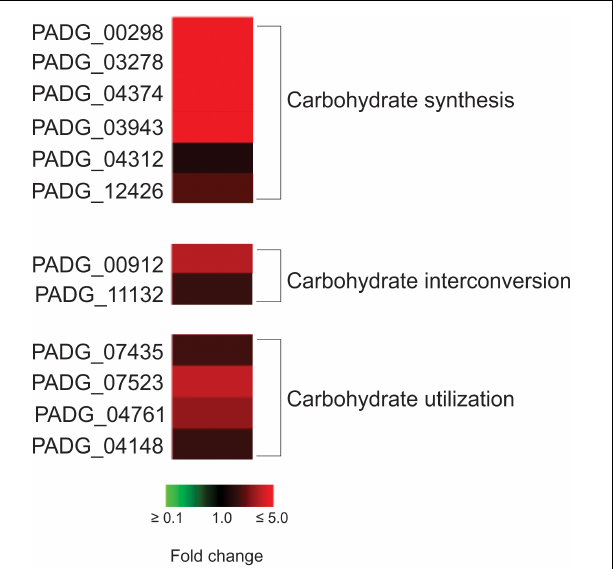
FIGURE 4 | Heat map of proteins related to carbohydrate synthesis, interconversion, and utilization. The proteins related to these processes are predominalty up-regulated in P. brasiliensis during interaction with non-primed macrophages. PADG_00298, FGGY-family carbohydrate kinase; PADG_03278, inositol-3-phosphate synthase; PADG_04374, UTP-glucose-1-phosphate uridylyltransferase; PADG_03943, phosphomannomutase; PADG_04312, UDP- N -acetylglucosamine pyrophosphorylase; PADG_12426, 1,4-alpha-glucan-branching enzyme; PADG_00912, UDP-galactopyranose mutase; PADG_11132, phosphoglucomutase; PADG_07435, sorbitol utilization protein SOU2; PADG_07523, neutral alpha-glucosidase AB; PADG_04761, mannosyl-oligosaccharide glucosidase; PADG_04148,